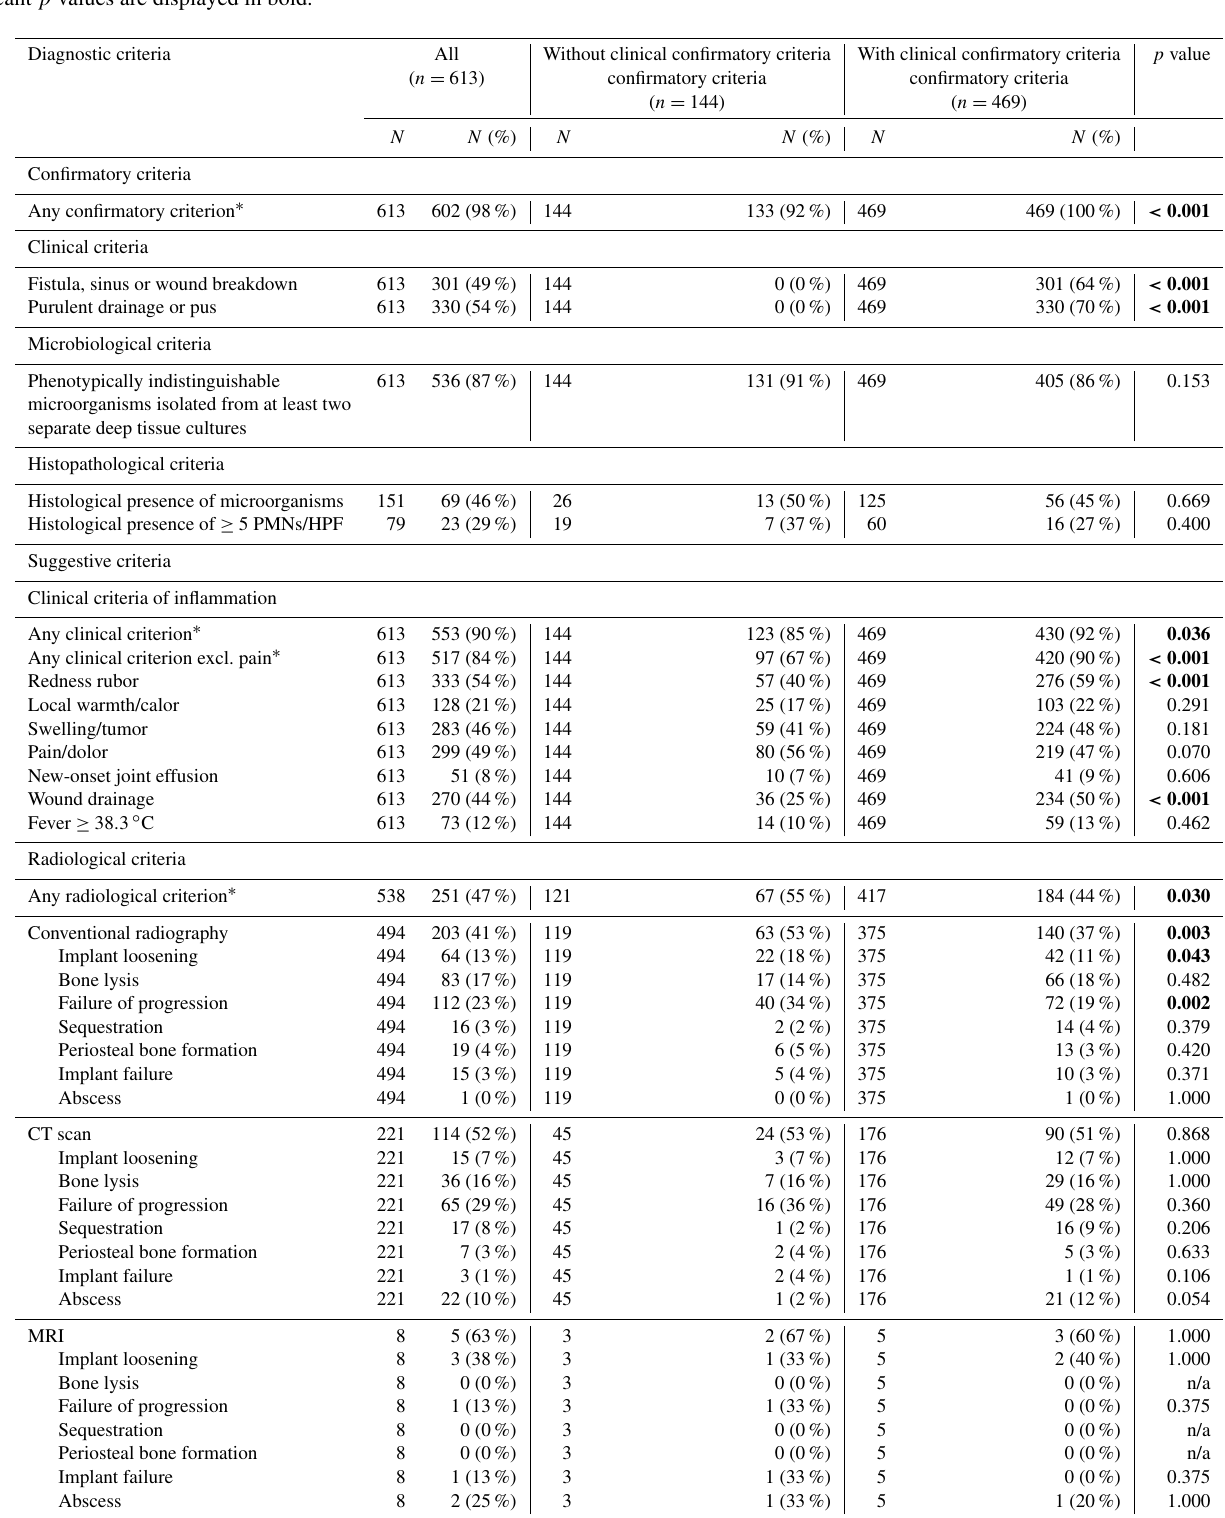
Table 3. Prevalence of FRI criteria for the total population and the subpopulation without clinical confirmatory criteria. Statistically signifi- cant p values are displayed in